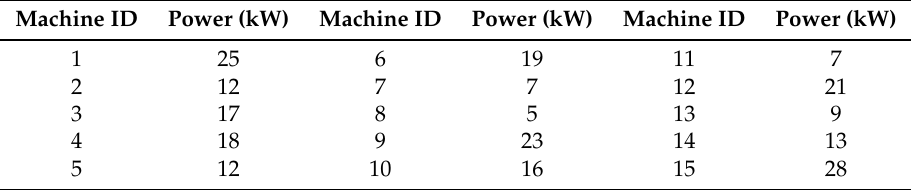
Table 3. Machine power values used in